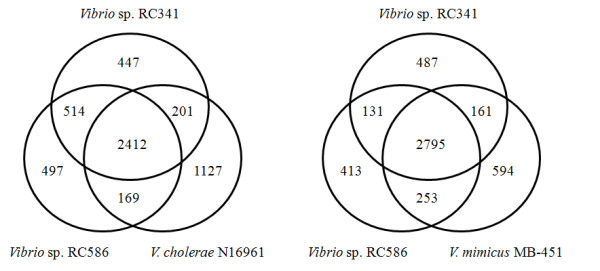
Venn diagrams showing ORFs shared by Vibrio sp. RC341, Vibrio sp. RC586, V. cholerae N16961, and V. mimicus MB-451. The number in the middle shows the conserved number of ORFs shared by the three strains. The numbers show that there are ORFs unique to that strain or that there are ORFs shared.